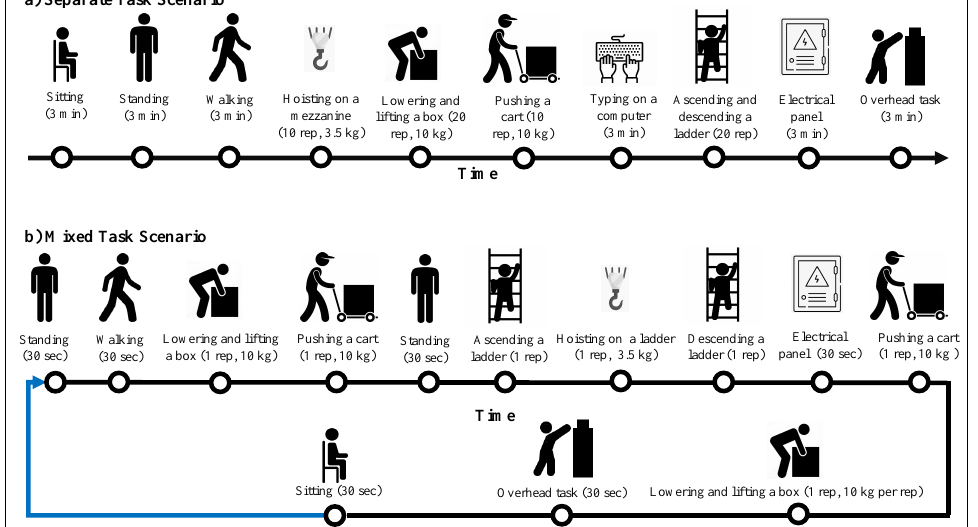
Figure 2. The timeline of experimental